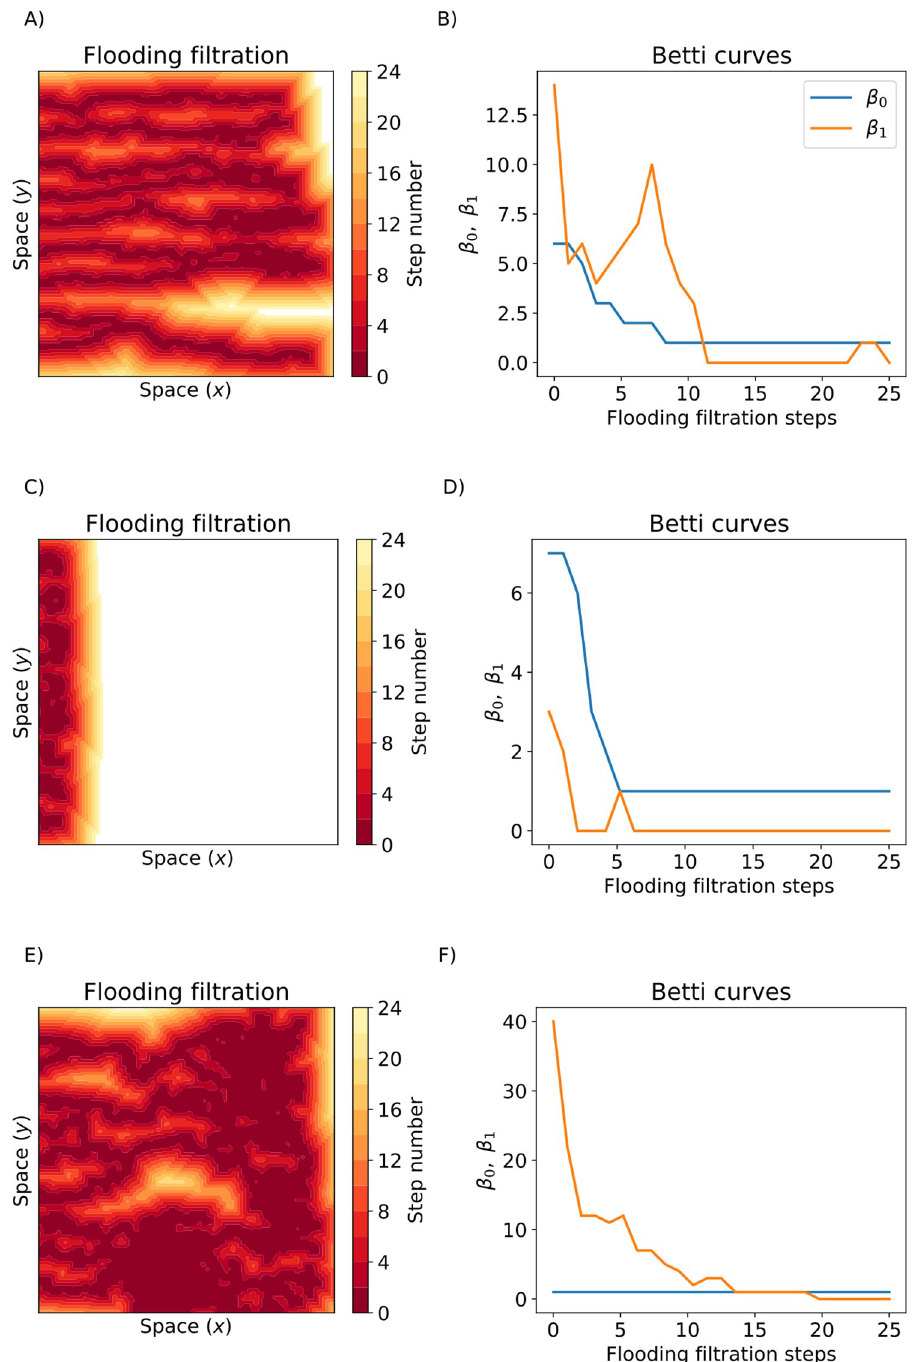
Fig 11. The flooding filtration. A,C,E) Illustrate the flooding filtrations for the three blood vessel simulations from Fig 7. Dark red pixels were points included in the first steps of the filtration and yellow pixels were the points included in later filtration steps. White pixels were not included after 24 steps of the flooding filtration. B,D,F) The Betti Curves ( β 0 ( K flood ) and β 1 ( K flood )) for the chemotaxis-driven, haptotaxis-driven, and chemotaxis and haptotaxis simulations respectively.